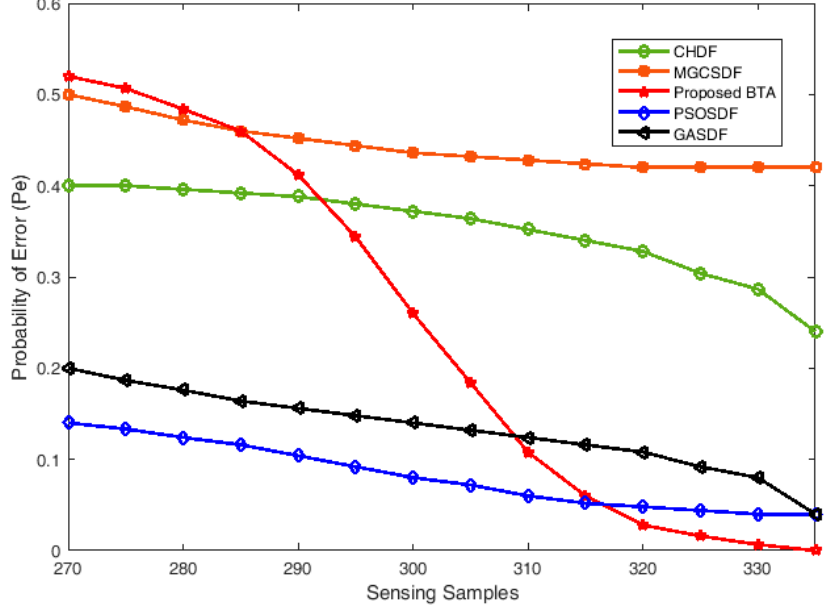
Figure 12. Probability of error vs. sensing samples under YES users.